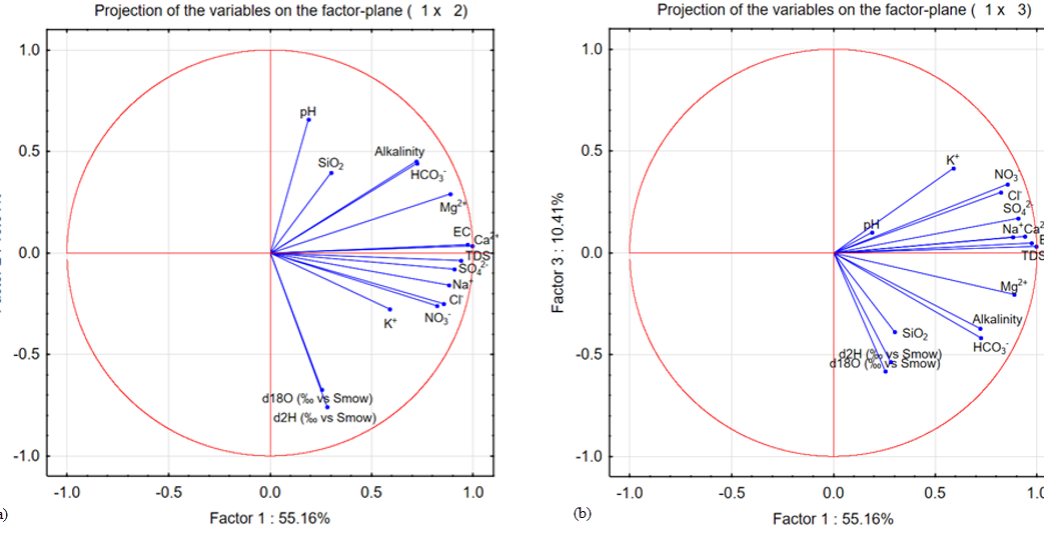
Figure 10. Space of the variables of the factorial plane: ( a ) F1-F2; ( b ) F1-F3. Table 4. Factorial weights of principal main components (With rotation).